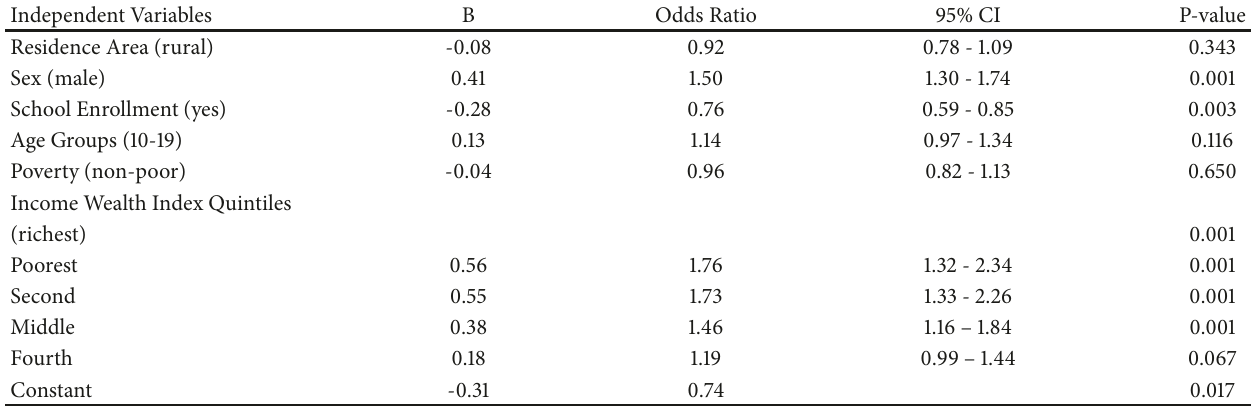
Table 4: Logit model analysis of prevalence of